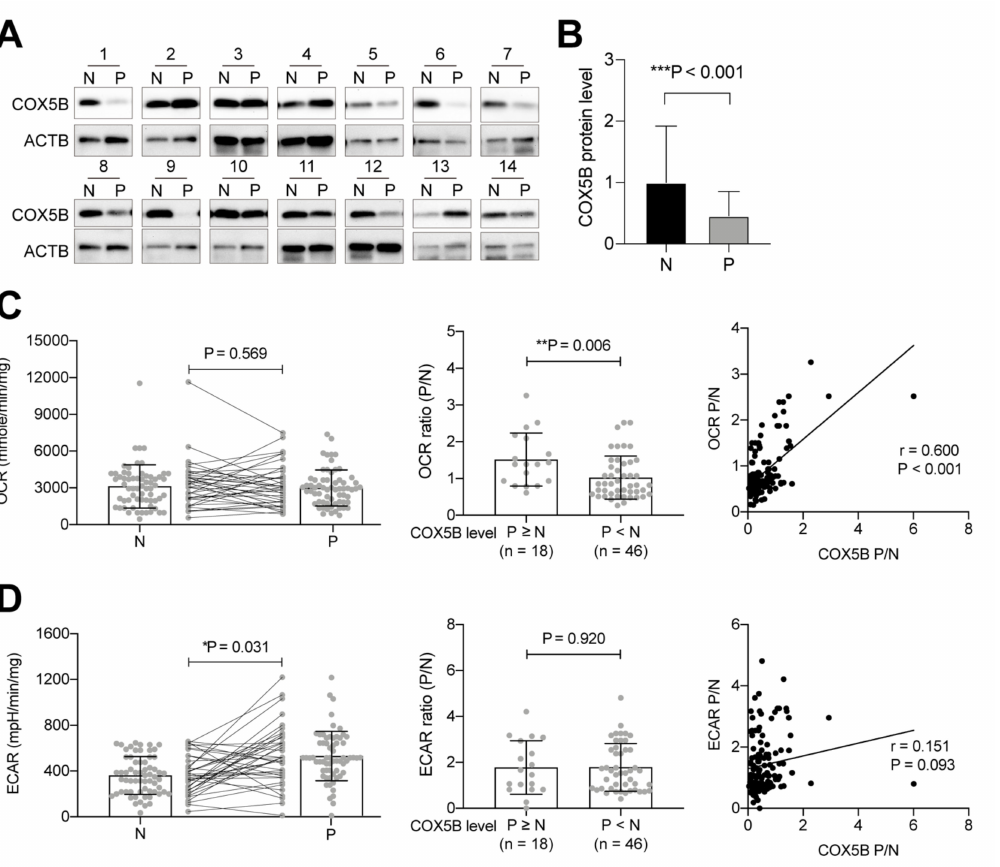
Figure 2. The increase of COX5B in adenomatous polyps is associated with elevated OCR. ( A ) The representative images of Western blot analysis of lysates from both normal mucosae (N) and polyps (P) tissues. COX5B, Cytochrome c Oxidase subunit 5B; ACTB, Actin Beta. The quantification results were shown in the ( B ), analyzed by two-tailed paired Student’s t -test. ( C , D ) The OCR and ECAR in either normal mucosa (N) and polyp (P) tissue. The p values in the left panels were acquired by two-tailed paired Student’s t -test, while two-tailed unpaired Student’s t -test was used for the middle panel. *, p < 0.05; **, p < 0.01; ***, p < 0.001. The Pearson correlation analysis was employed for the right